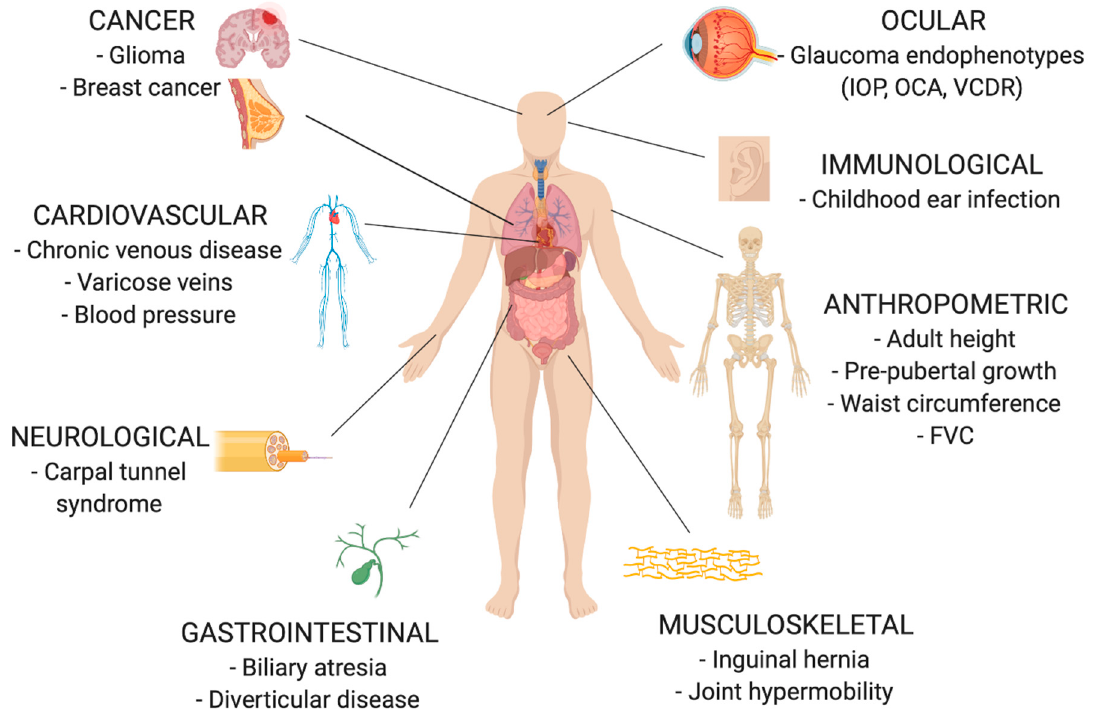
Figure 5. Pathophysiological associations of EFEMP1 discovered in genome-wide association studies.